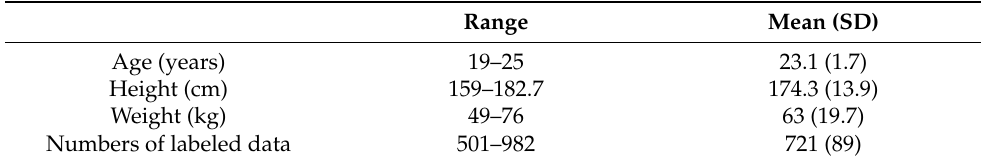
Table 2. Statistics of the 7 participants in the dataset.